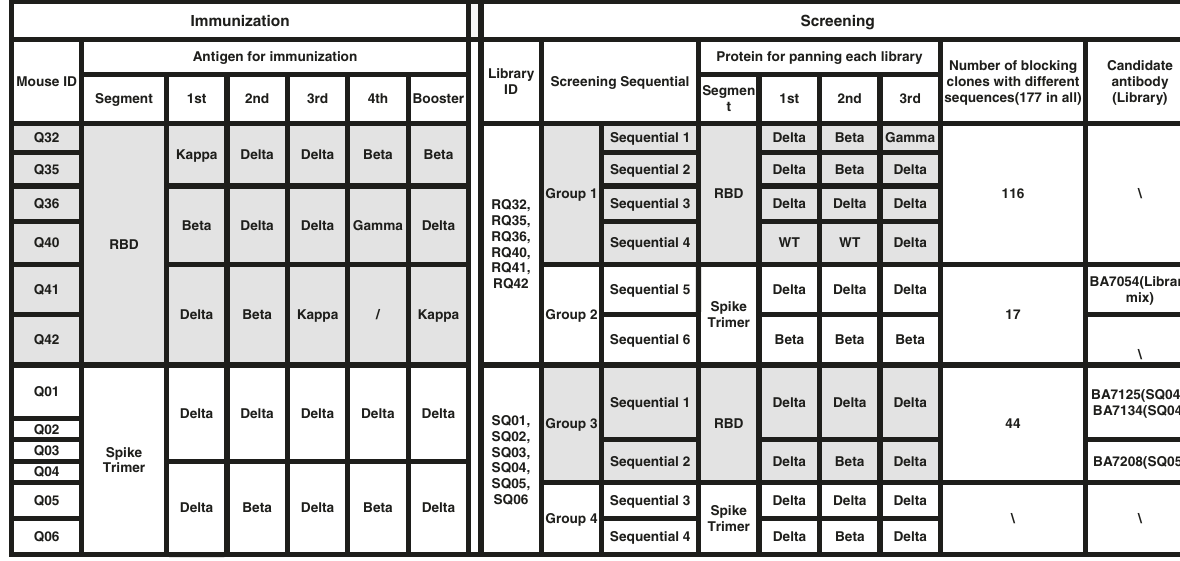
Table 1 Sequential immunization and sequential screening regimen.